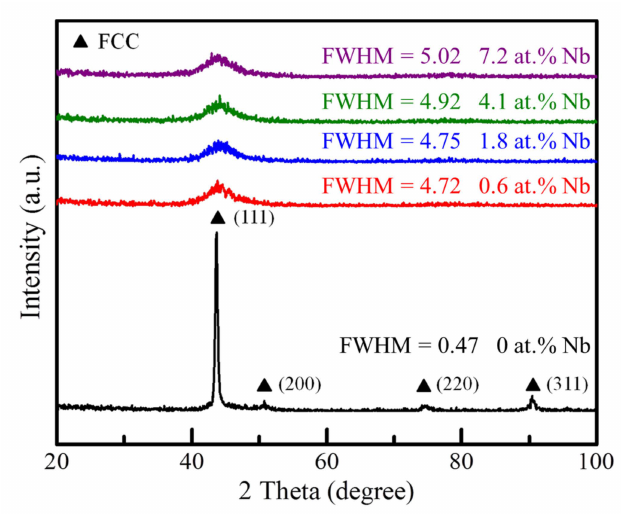
Figure 2. XRD patterns of the Nb x -CoCrFeMnNi